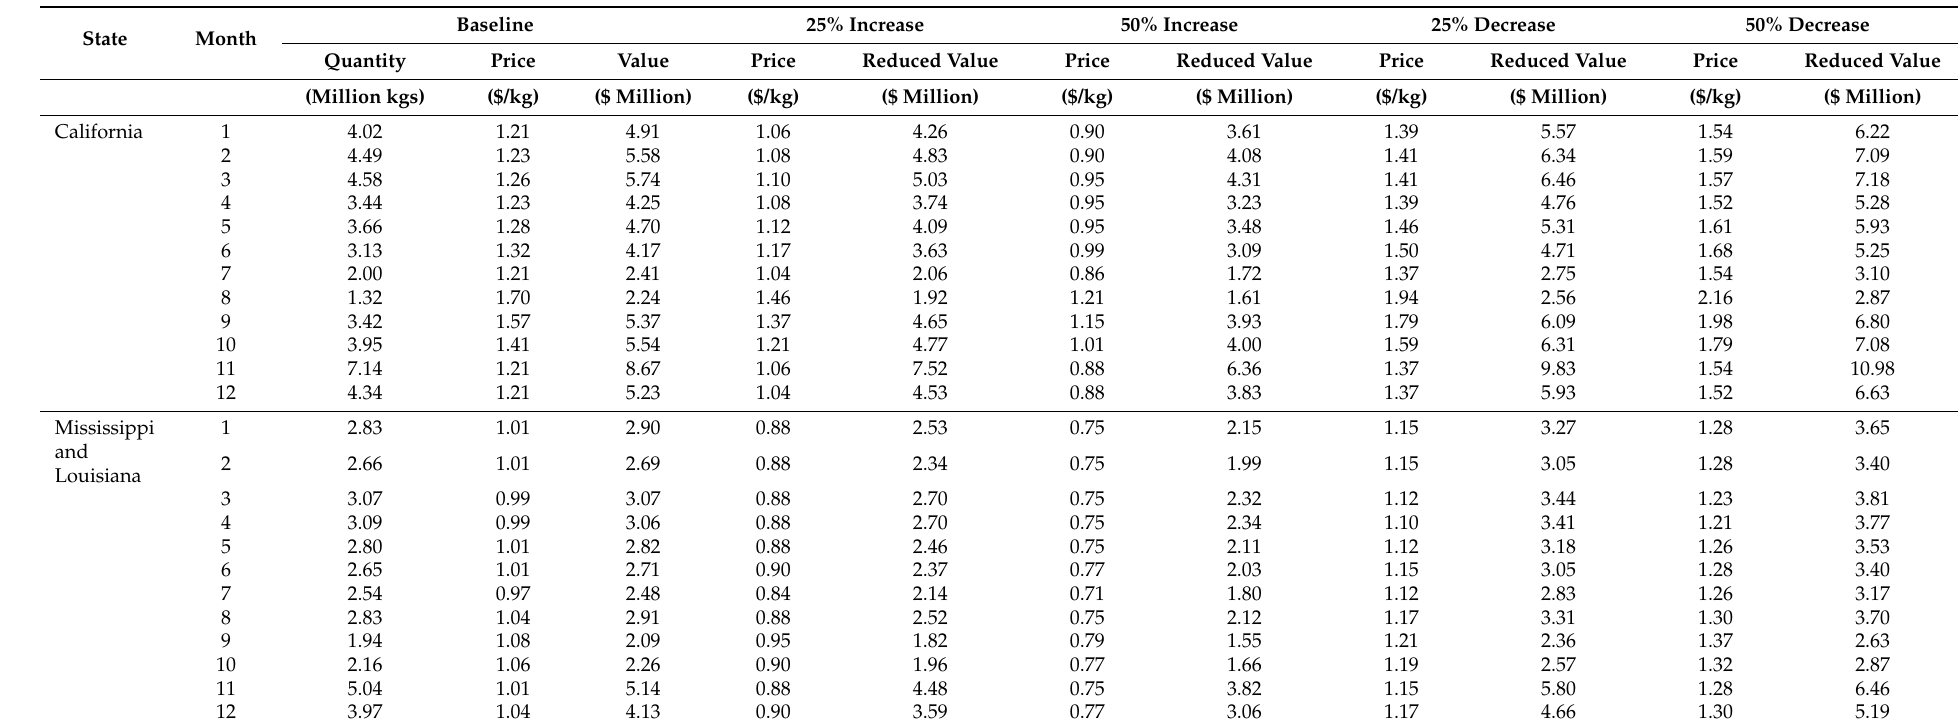
Table A1. Effects of North Carolina supply changes on monthly prices and shipment values of sweet